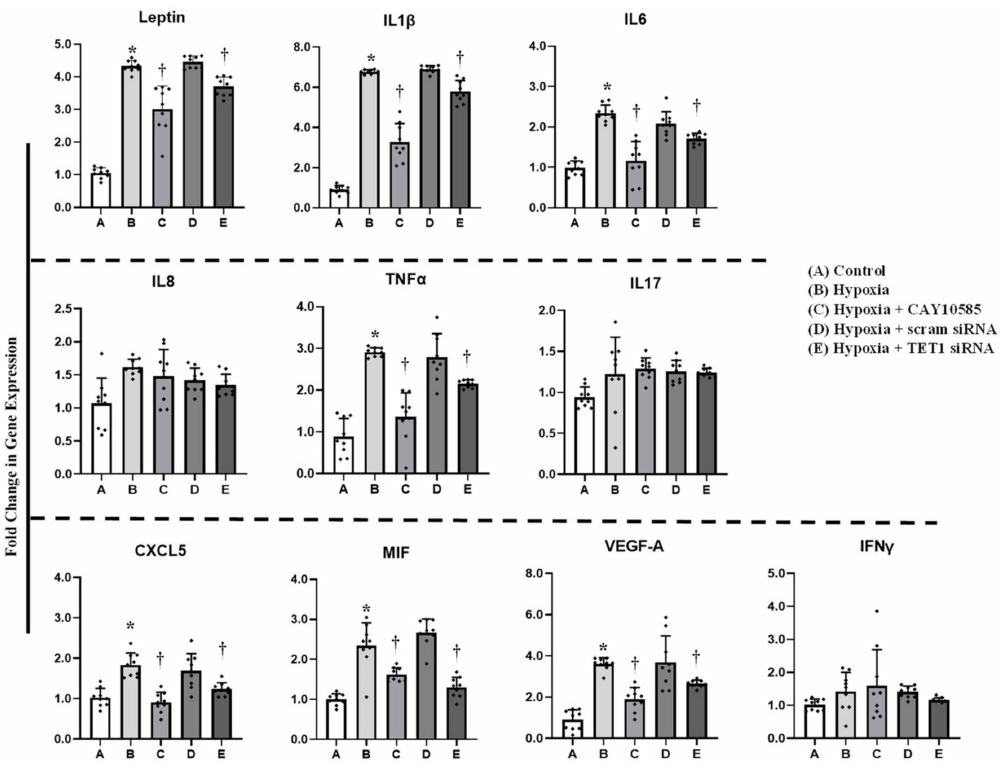
Figure 5. E ff ect of hypoxia and HIF1 α / TET1 pathway on adipocytokine gene expression. Quantitative assessment by real-time PCR of mRNA levels of leptin, IL1 β , IL6, IL8, TNF α , IL17, CXCL5, MIF, VEGFA, and IFN γ normalized to the house keeping gene, β -actin. Primary adipocytes were cultured for 24 h under conditions of hypoxia ± CAY10585 or silenced TET1 compared to standard culturing conditions (control). Results represent the means ± SD for three independent experiments in triplicates for each treatment (n = 9). (* p < 0.05) for comparison with control and ( † p < 0.05) for comparison with